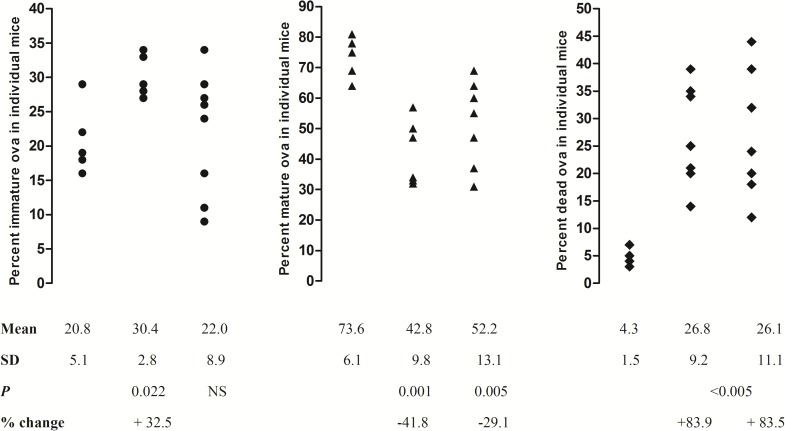
Effect of immunization with SmCB1 and SmCL3 on S. mansoni egg development.Percent immature (left box), mature (middle box) and dead (right box) ova was assessed seven weeks after infection with 150 S. mansoni cercariae in CD1 mice (6-8/group) that were unimmunized (left column in each box) or immunized with SmCB1 (middle column in each box) or SmCL3 (right column in each box). P values as assessed by the Mann-Whitney test; NS = not significant.